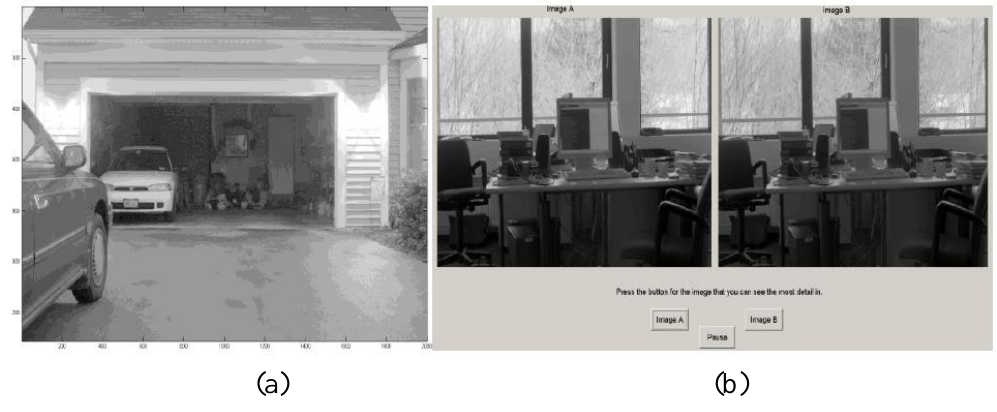
Figure 8. Visual Perception Study Images. (a) An example image from the target detection task. (b) Is an example image of the paired comparison